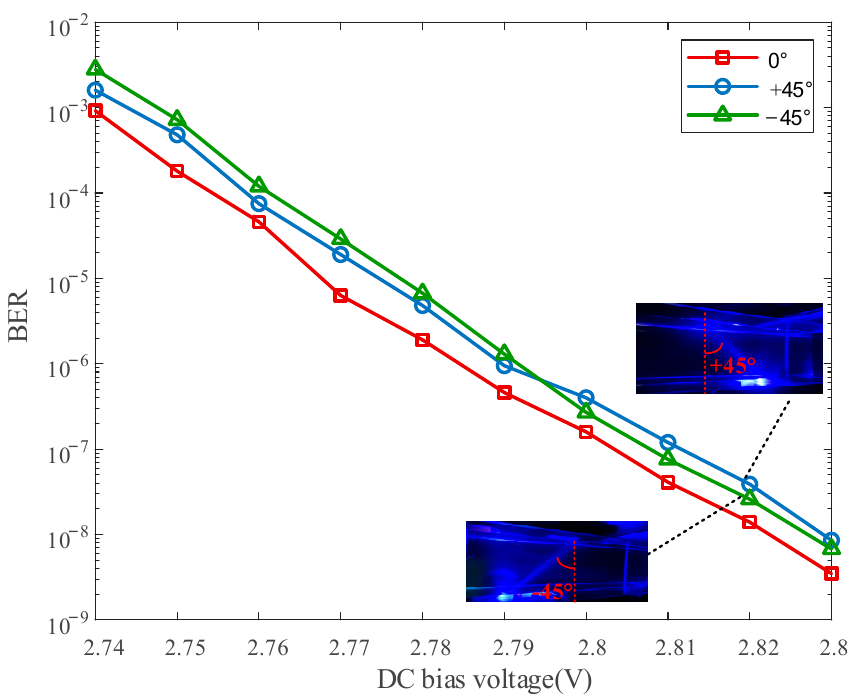
Figure 12. BER performance of the received signals at different DC bias voltages.